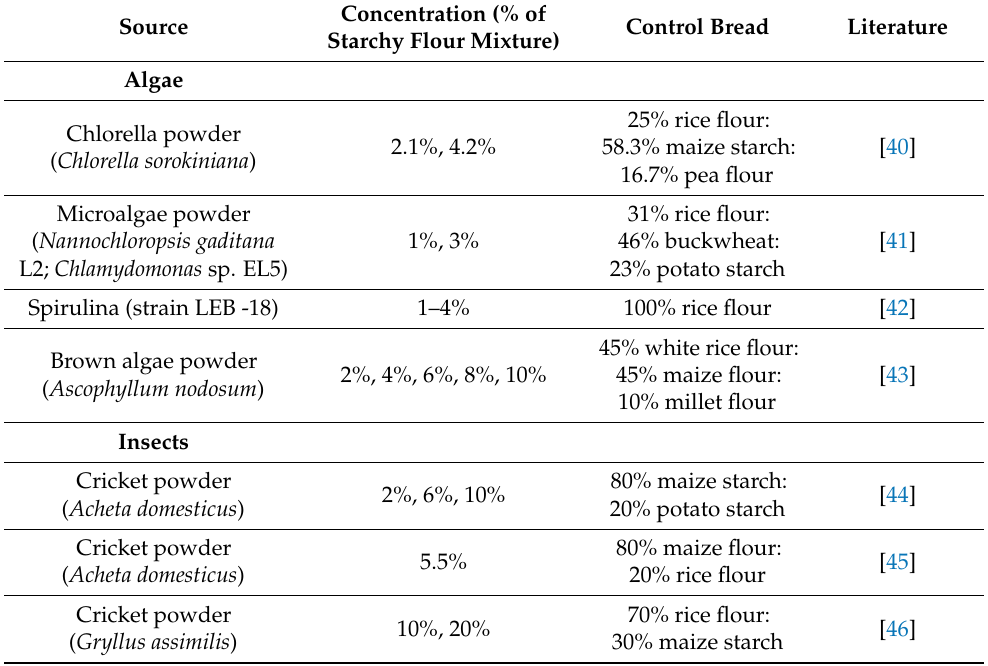
Table 3. Different high protein sources from algae and insects reported in recent published literature to enrich gluten-free